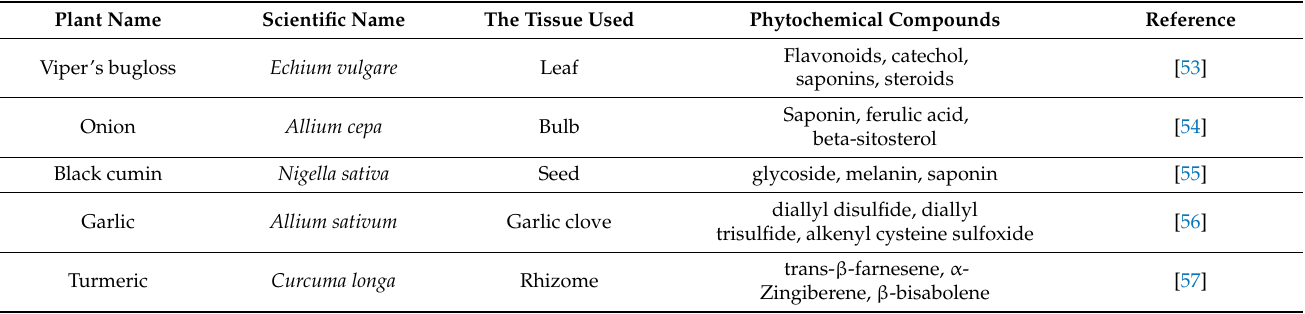
Table 2. Phytochemical compounds present in some plant